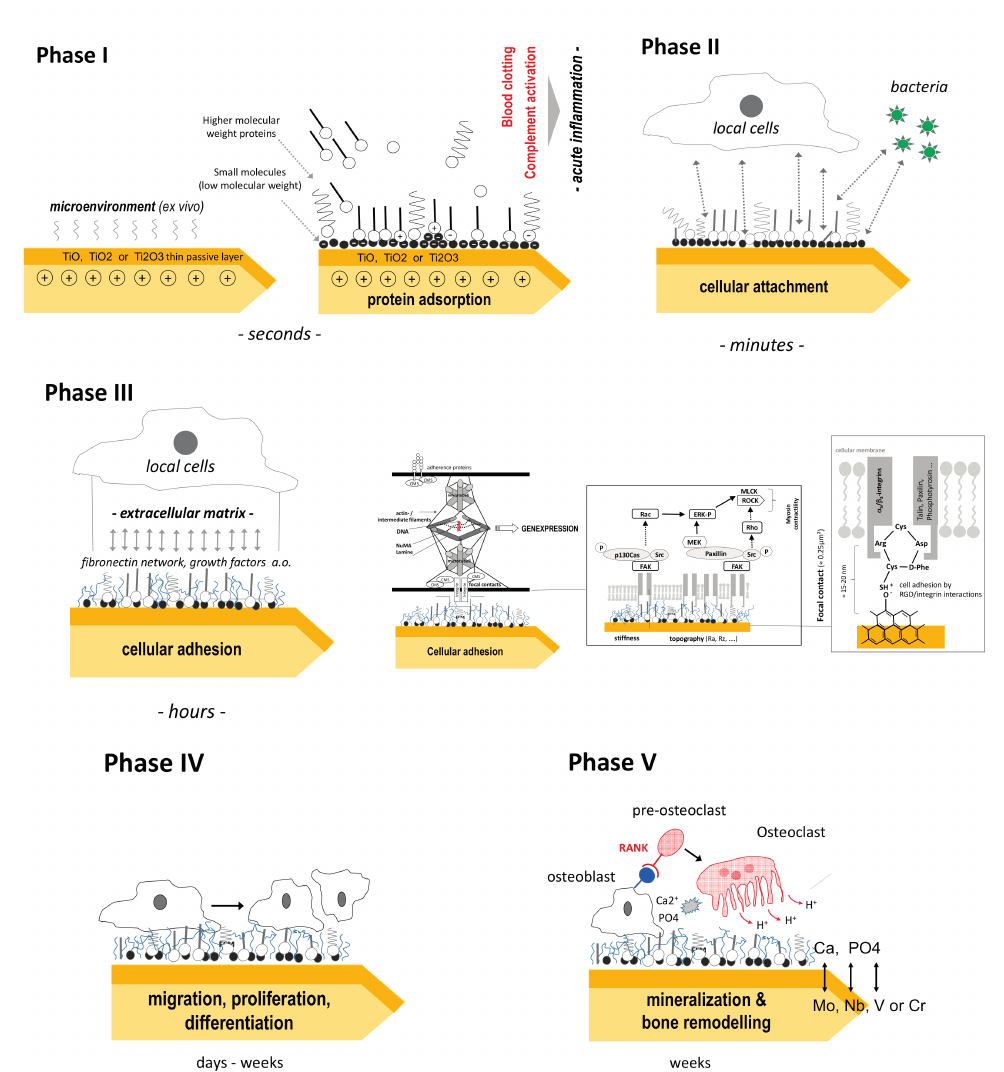
Figure 1. Local reactions onto titanium surfaces after in vivo